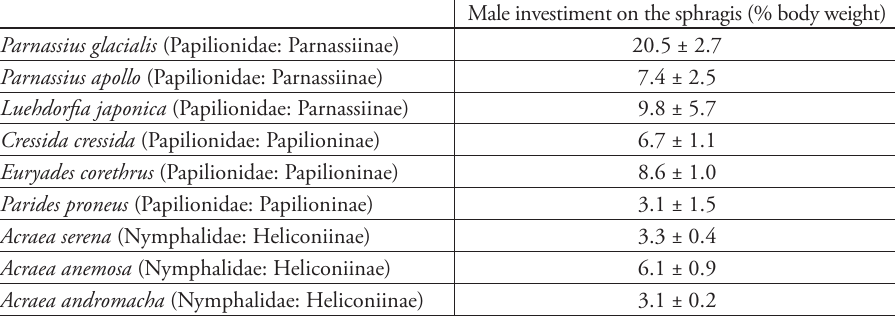
Table 1. Percentage of male investment in the sphragis based on male’s weight. Data adapted from Orr (1988). Male investiment on the sphragis (% body